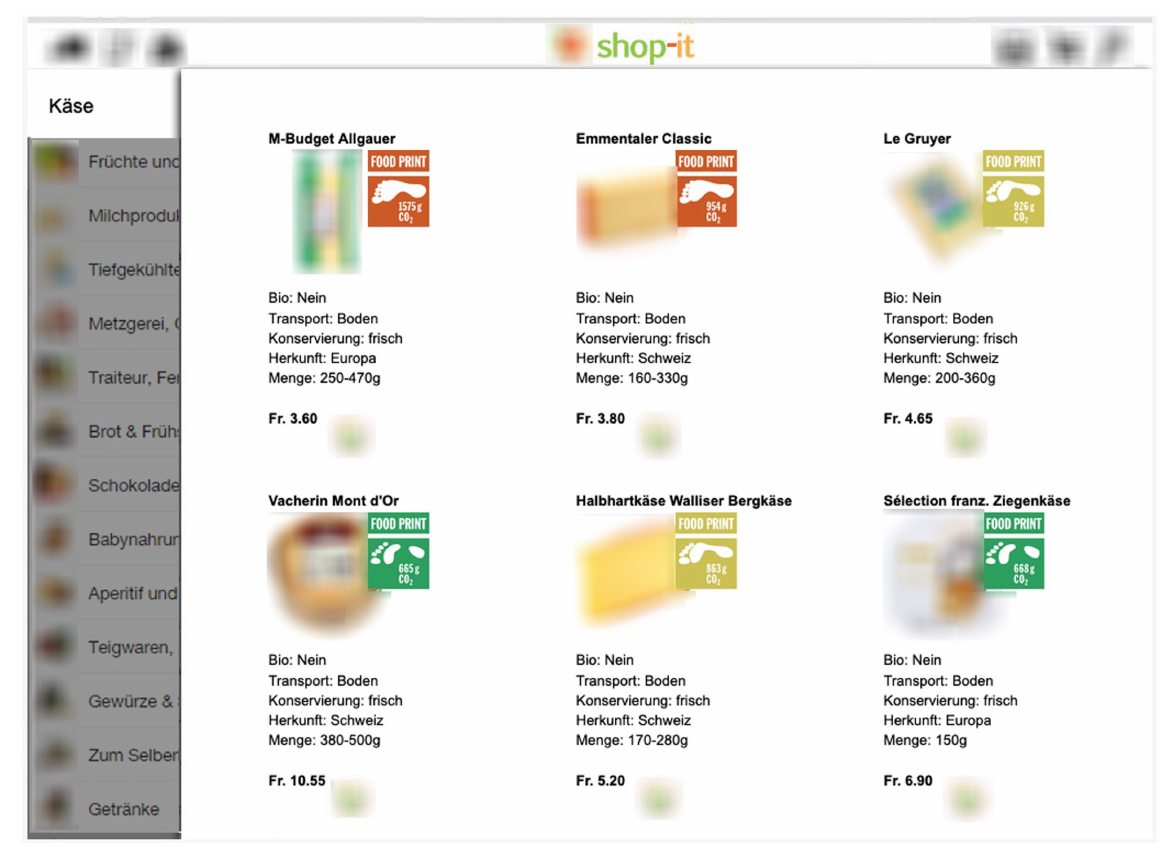
FIGURE 3 Stimulus material. Examples of the choice task in the TLL